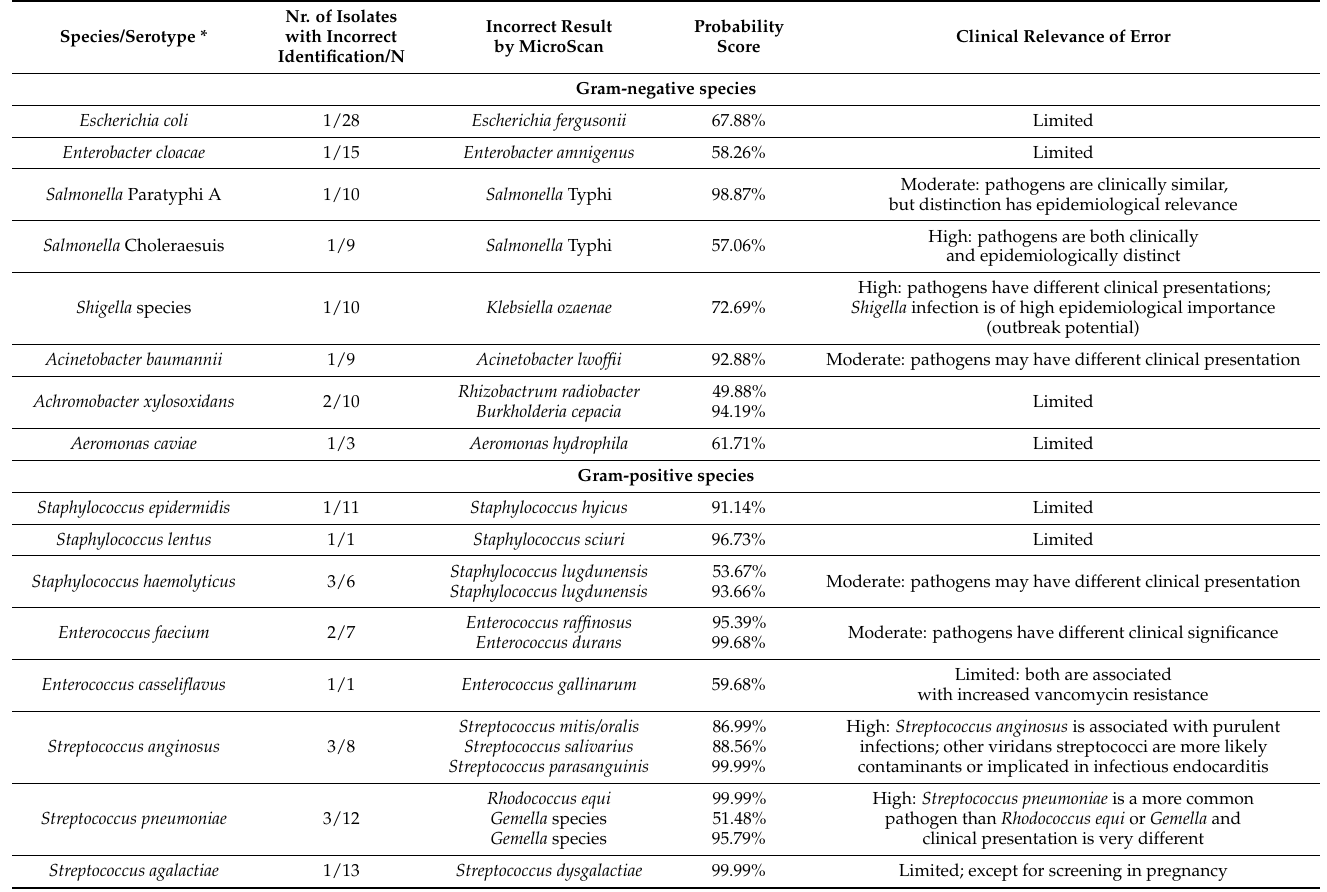
Table 4. Details of incorrectly identified isolates. Potential clinical relevance is also indicated; limited clinical relevance means that the two pathogens are similar in clinical, epidemiological, and infection control aspects. Probability scores are reported by the MicroScan LabPro software with two decimals. A probability score of ≥ 85.00% is considered as “high probability”. N = total number of isolates tested. * As identified by matrix-assisted laser desorption/ionization time-of-flight mass spectrometry (MALDI-TOF) (and serotyping when